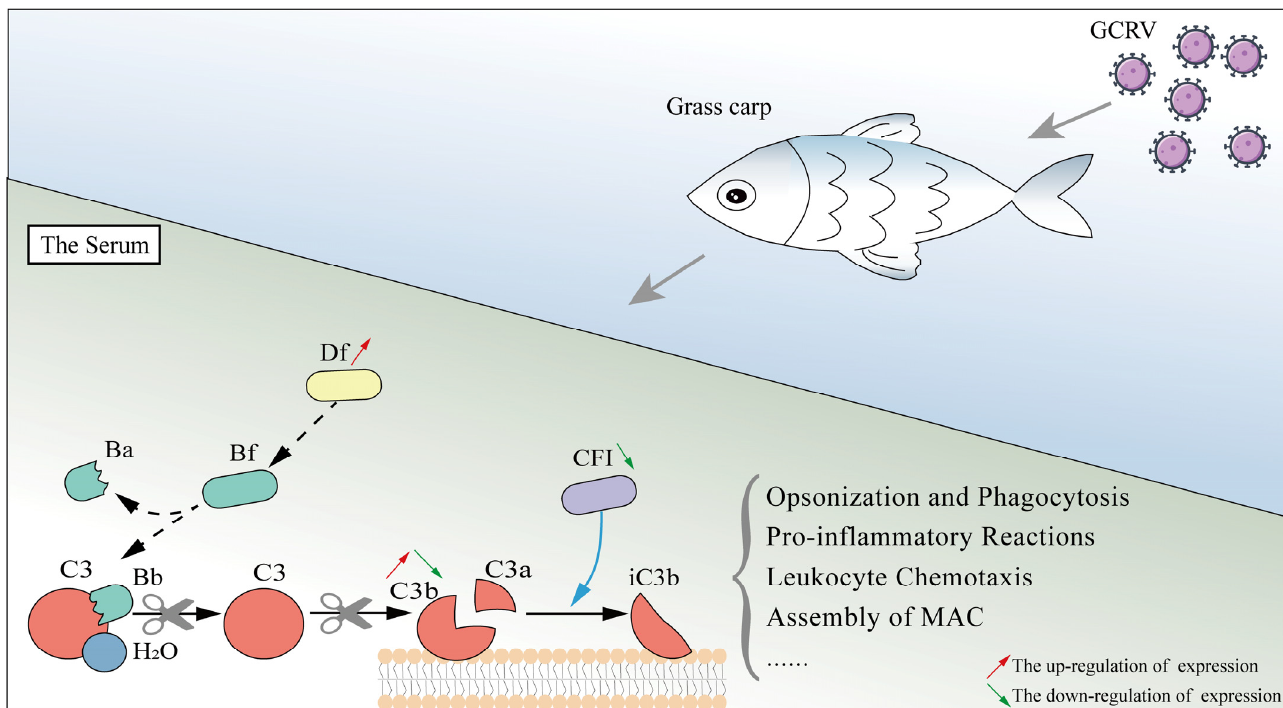
Figure 10. The schematic diagram of the complement regulatory mechanism mediated by Df and CFI during GCRV infection in C. idella . Df, a complement enhancer, shows continuously up-regulated expression levels in the grass carp during GCRV infection, and has previously been verified to promote the production of C3b, possibly by cleave Bf. In contrast, CFI, a complement inhibitor, continues to decline during GCRV infection from the early stage at the incubation period to the late stage at the restored period in the grass carp. Correspondingly, the content of serum C3b first increases and peaks at the death period, and eventually returns to the initial level at the restored period post GCRV infection in the grass carp. C3a and C3b produced by the cleavage of C3 can trigger diverse immune responses including opsonization and phagocytosis, pro-inflammatory reactions, leukocyte chemotaxis, the assembly of MAC, etc., in the grass carp serum.